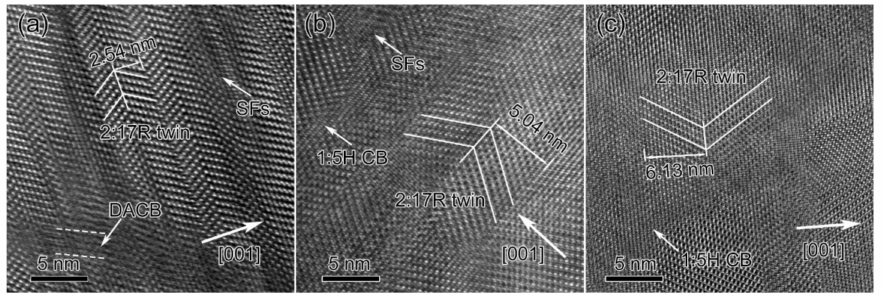
Figure 4. HR-TEM images of the grain interiors for Sm 25 Co 46.9 Fe 19.5 Cu 5.6 Zr 3.0 magnets. Solution- treated ( a ), aged for 0.5 h at 810 ◦ C ( b ), and the final magnet ( c